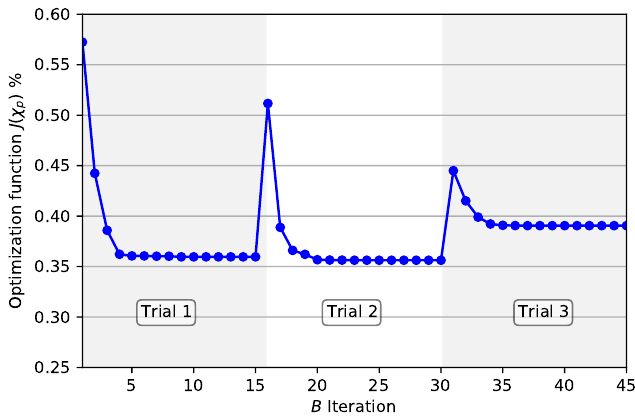
Figure 14. Proposed algorithm performance for the SDM using the KC200GT SPVM.